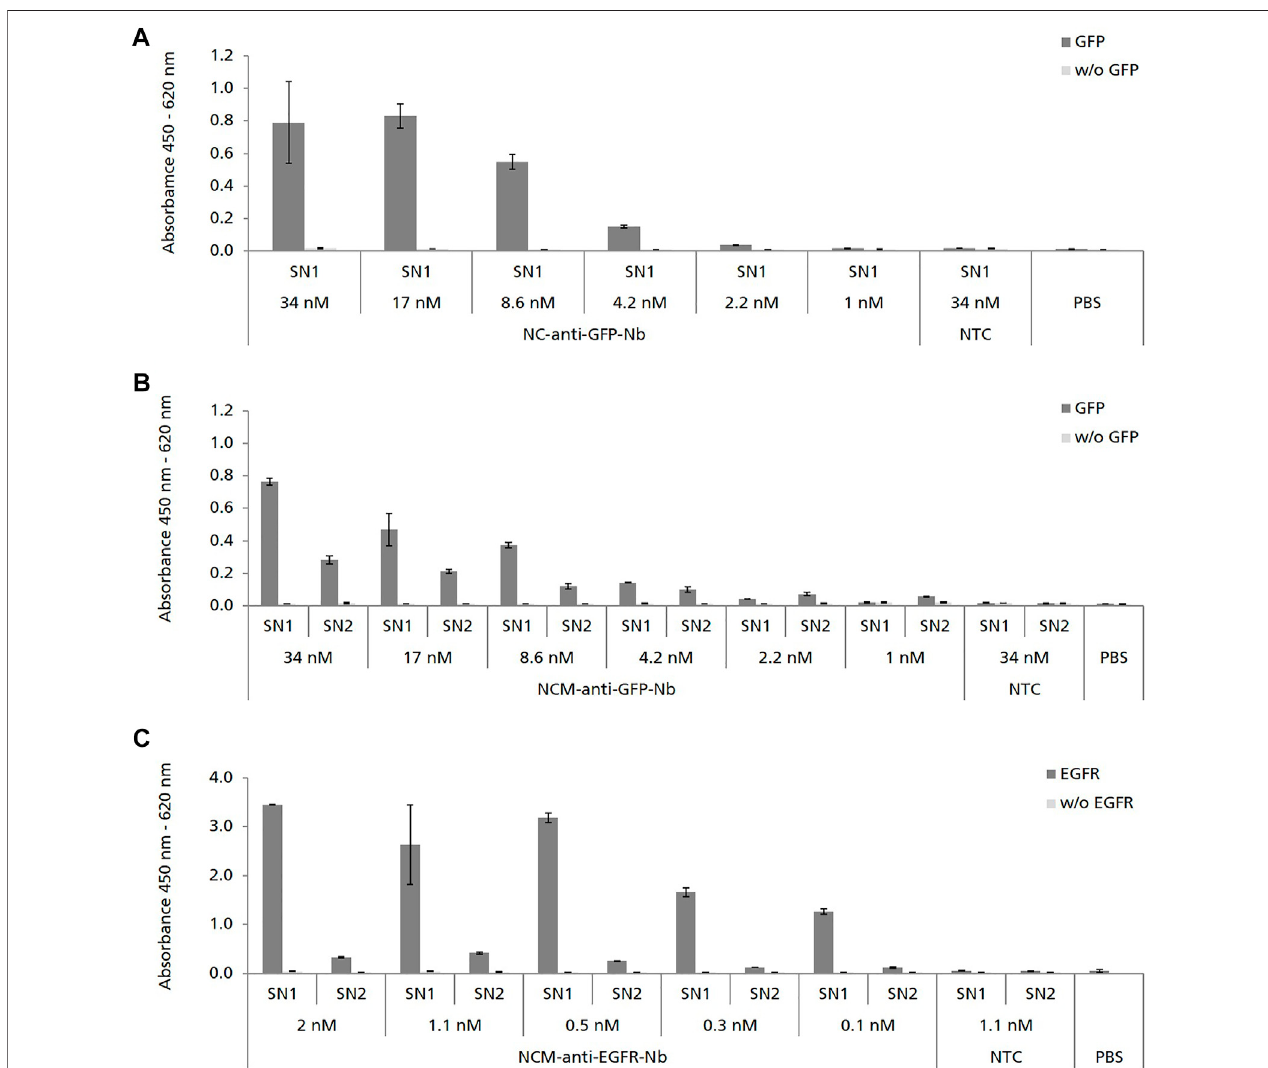
FIGURE 3 | ELISA analysis showing the speci fi c binding of cell-free synthesized Nbs to their corresponding antigens. Nbs without signal sequence (NC) were analyzed in SN1 (comprising non-translocated Nbs). Nbs with signal sequence (NCM) were analyzed in SN1 and additionally in SN2 (comprising Nbs which were solubilized from the lumen of the endogenous CHO microsomes). No template control (NTC) and PBS were analyzed in parallel as negative controls. To monitor background binding Nb samples were also analyzed on wells coated without (w/o) antigen. (A,B) Binding of anti-GFP-Nb to its antigen green fl uorescent protein (GFP)wasanalyzedinserialdilutionsintherangeof34 – 1 nM. (C) Bindingofanti-EGFR-Nb toepidermalgrowthfactorreceptor(EGFR)wasanalyzedinserialdilutionsin the range of 2 – 0.1 nM. Standard deviations were calculated from quadruplicate analysis (A,B) and duplicate analysis (C)